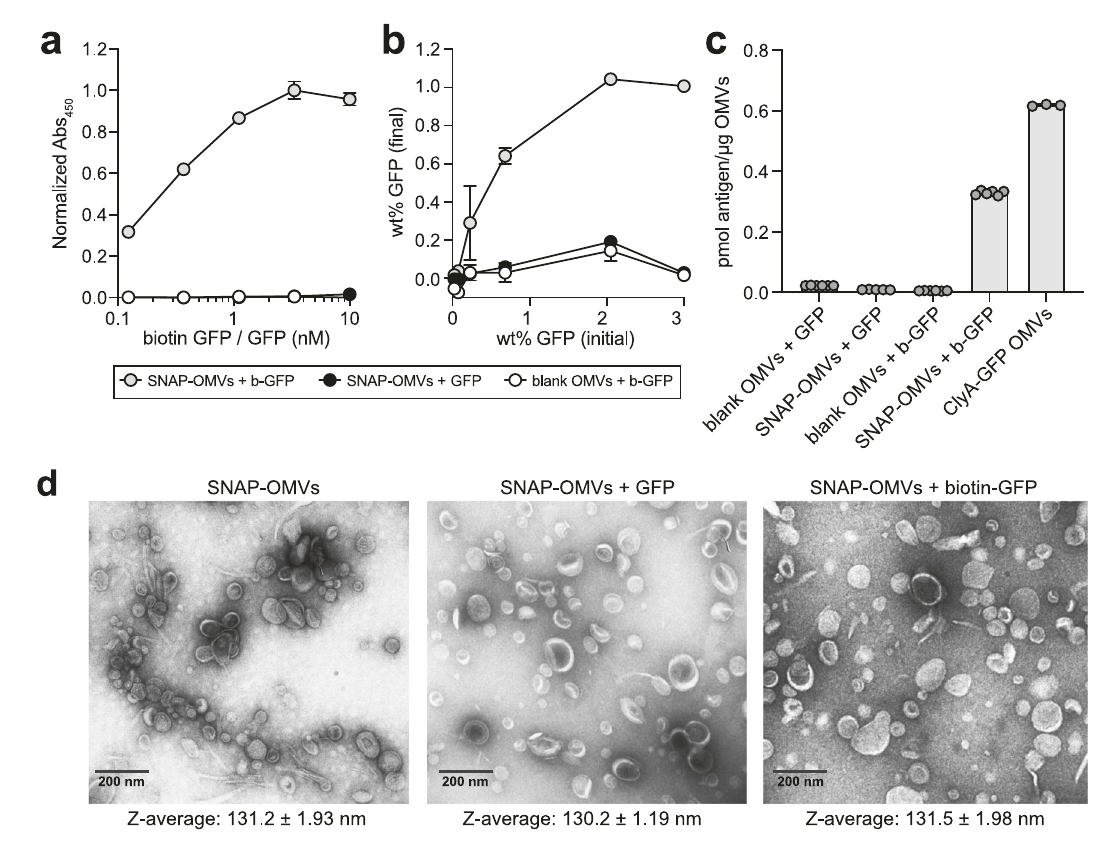
Fig.2|ChimericLpp-OmpA-eMASNAPenablescontrollableantigenloadingon OMVs. a Dose-response curve generated by loading biotin-GFP (b-GFP) or unmo- di fi ed GFP (GFP) on SNAP-OMVs isolated from hypervesiculating E. coli strain KPM404 Δ nlpI expressing the Lpp-OmpA-eMA construct from plasmid pTrham (induced with 0.5 mM L-rhamnose). Blank OMVs were isolated from plasmid-free KPM404 Δ nlpI cells.BindingactivitywasdeterminedbyELISAinwhichLpp-OmpA- eMASNAP-OMVswereimmobilizedonplatesand subjected tovaryingamountsof biotin-GFP,afterwhichplateswereextensivelywashedpriortodetectionofbound biotin-GFPusinganti-polyhistidineantibodytodetectC-terminal6xHistagonGFP. Data were normalized to the maximum binding signal corresponding to Lpp- OmpA-eMA SNAP-OMVs in the presence of 3.3nM biotin-GFP. Data are the mean±SDwith n =2biologicallyindependent experiments. b Same OMVsas in( a ) but dose-response was generated by fi rst incubating OMVs with biotin-GFP or unmodi fi